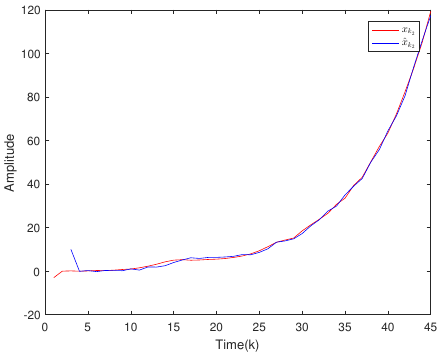
Figure 10. The state evolutions of x 2, k and corresponding estimates ˆ x 2, k .